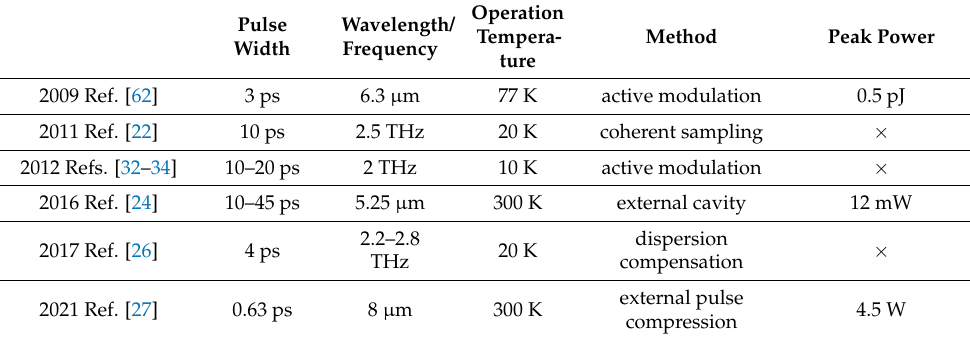
Table 1. Achievements on pulse generation from QCLs.